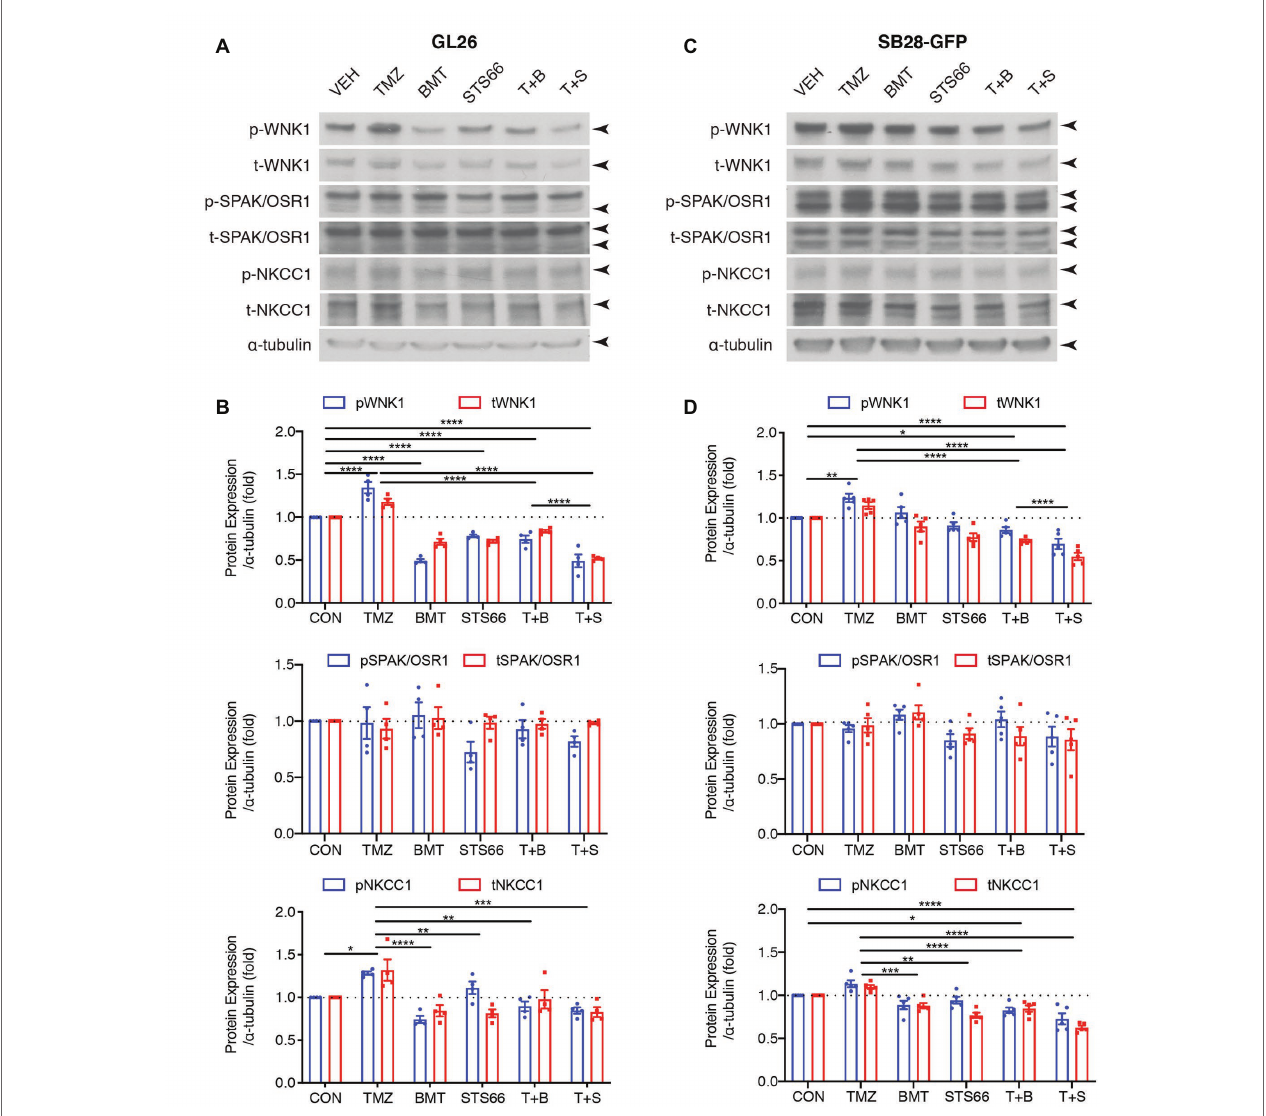
FIGURE 4 | STS66 reduced activation of WNK1-SPAK/OSR1-NKCC1 cascade in cultured glioma cells in response to TMZ. (A) Representative immunoblotting images of total (t-) or phosphorylated (p-) WNK1, SPAK/OSR1, and NKCC1. GL26 cells were exposed to DMSO (Veh), TMZ (100 μ M), BMT (10 μ M), STS66 (10 μ M), T + B, or T + S combined for 48 h. Cell lysates were harvested for immunoblotting. (B) Summary. Data are means ± SEM ( n = 4, 5), * p < 0.05, ** p < 0.01, *** p < 0.001, **** p < 0.0001. (C) Representative immunoblotting images of total (t-) or phosphorylated (p-) WNK1, SPAK/OSR1, and NKCC1. SB28-GFP cells were exposed to DMSO (Veh), TMZ (100 μ M), BMT (10 μ M), STS66 (10 μ M), T + B, or T + S combined for 48 h. (D) Summary. Data are means ± SEM ( n = 4, 5), * p < 0.05, ** p < 0.01, *** p < 0.001, **** p <